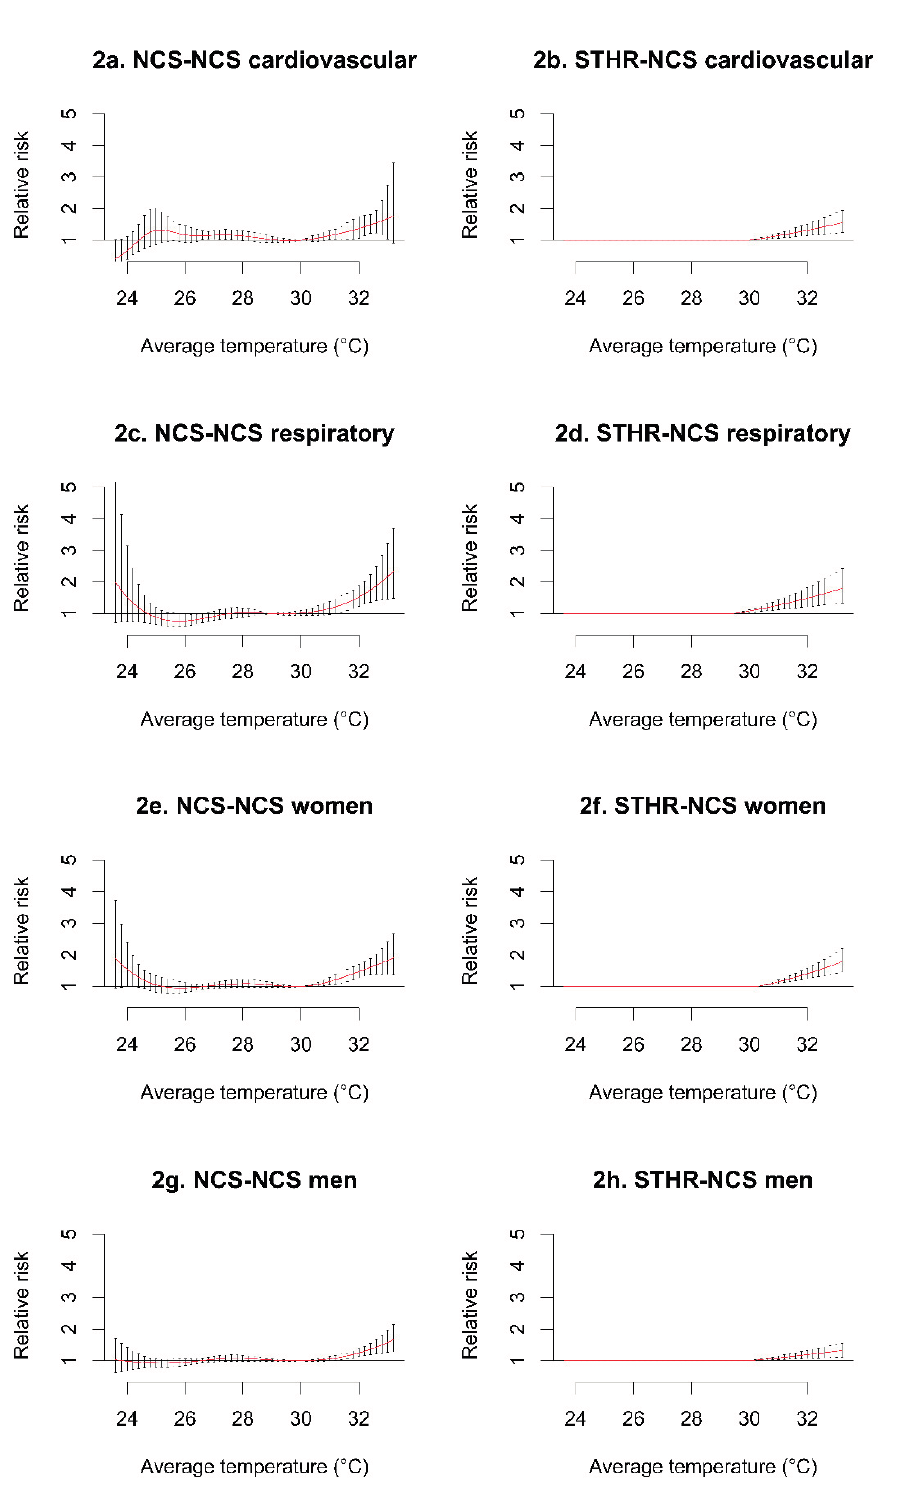
Figure 2. Cause-specific ( a–d ), and sex-specific mortality ( e-h ) relative risk in the NCS-NCS, and STHR-NCS models. The upper thresholds in the STHR-NCS models were based on the respective minimum mortality points. NCS: natural cubic spline, STHR: single high